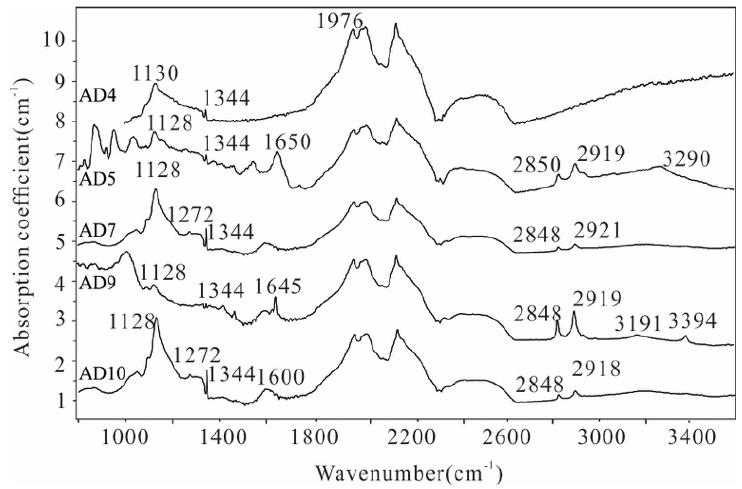
Figure 4. Infrared absorption spectrum collected from diamonds exhibiting C centres. Bands or lines corresponding to B and B’ centres were found co-existing in sample